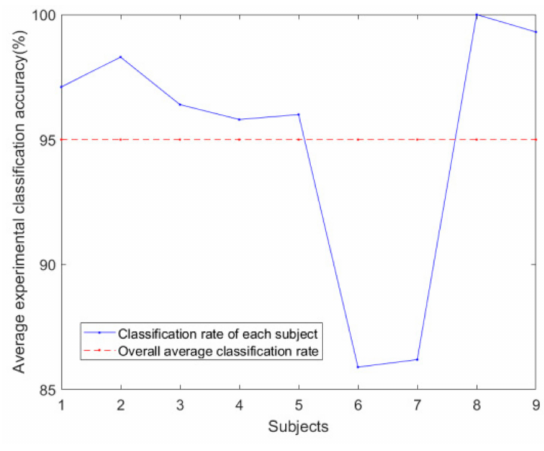
Figure 10. Classification accuracy comparison.